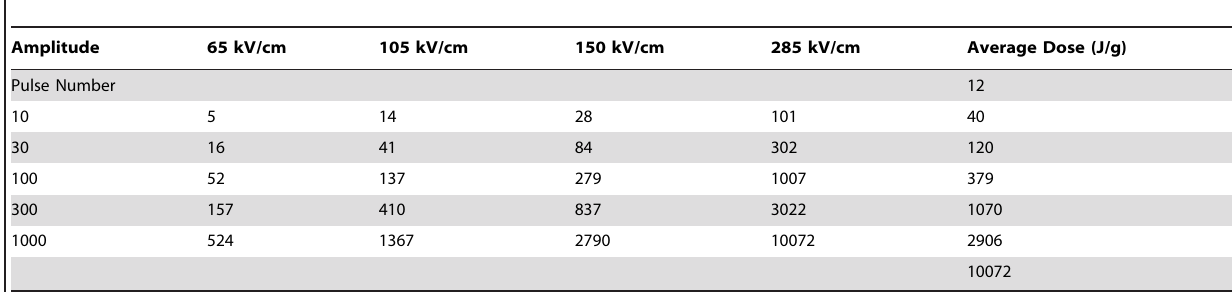
Table 1. Exposure parameters used in this study and the calculated dose delivered to the cuvette.